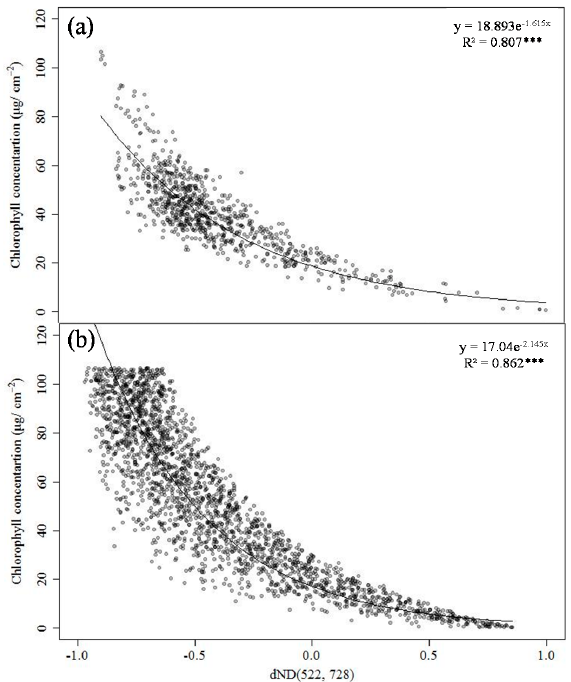
Figure 13. The relationship between dND (522, 728) and chlorophyll content ( a ) for measured datasets and ( b ) a simulated dataset from PROpriétés SPECTrales (PROSPECT) Version 5 (*** indicates p < 0.001).